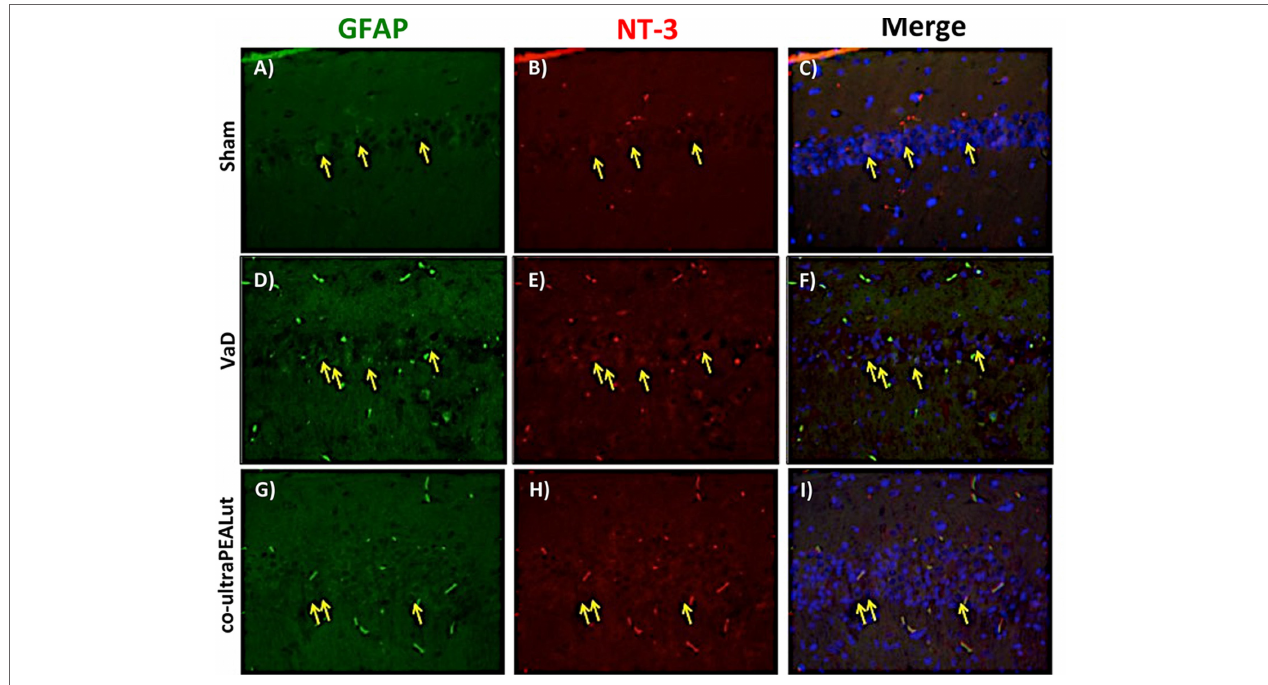
FigUre 11 | co-localization of gFaP/nT-3 after carotid arteries ligation . Results are shown for Sham group (a–c) , mice after carotid arteries ligation (D–F) , mice treated with co-ultraPEALut (g–i) . Brain sections were double stained with antibodies against GFAP [ (a,D,g) , green] and NT-3 [ (B,e,h) , red]. Hippocampal sections revealed increased astrogliosis (D) in VaD group. GFAP immunoreactivity was reduced in co-ultraPEALut-treated mice (g) . Yellow spots indicate co-localizations and revealed a high co-localization between GFAP/NT-3 double staining (c,F,i) . The pictures are demonstrative of at least three experiments executed on distinctive experimental days. Images are representative of all the animals in every group. All images were digitalized at a resolution of 8 bits into an array of 2,048 × 2,048